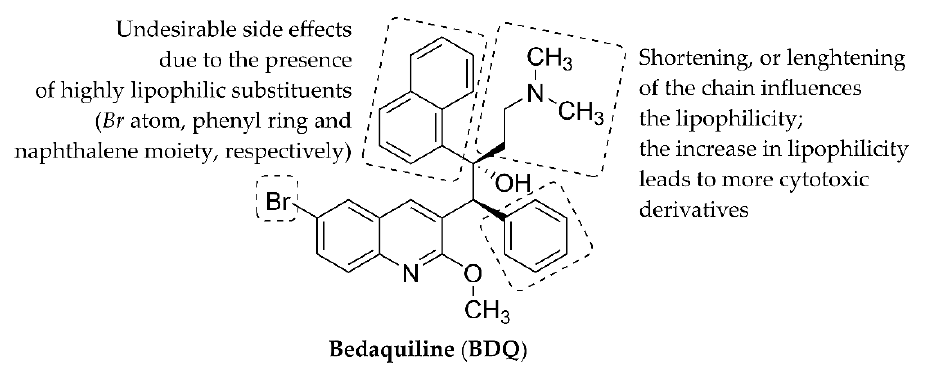
Figure 5. Chemical structure of bedaquiline ( BDQ ) and its structural modifications that lead to more cytotoxic derivatives or to molecules showing undesirable side effects.